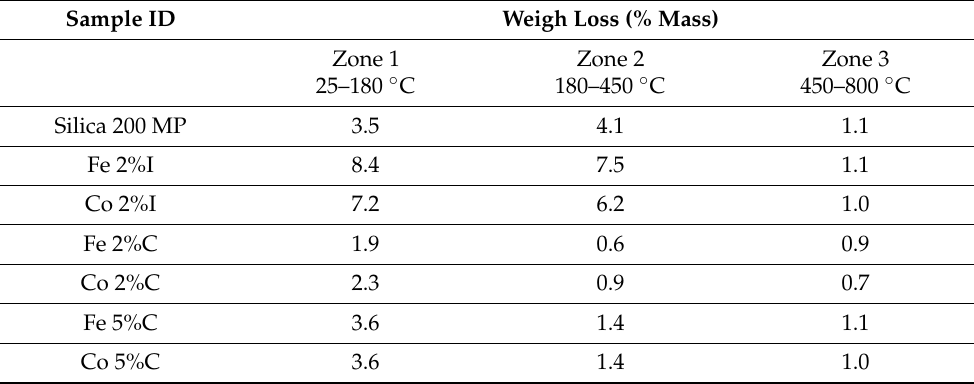
Table 1. Samples weight loss in function of catalyst